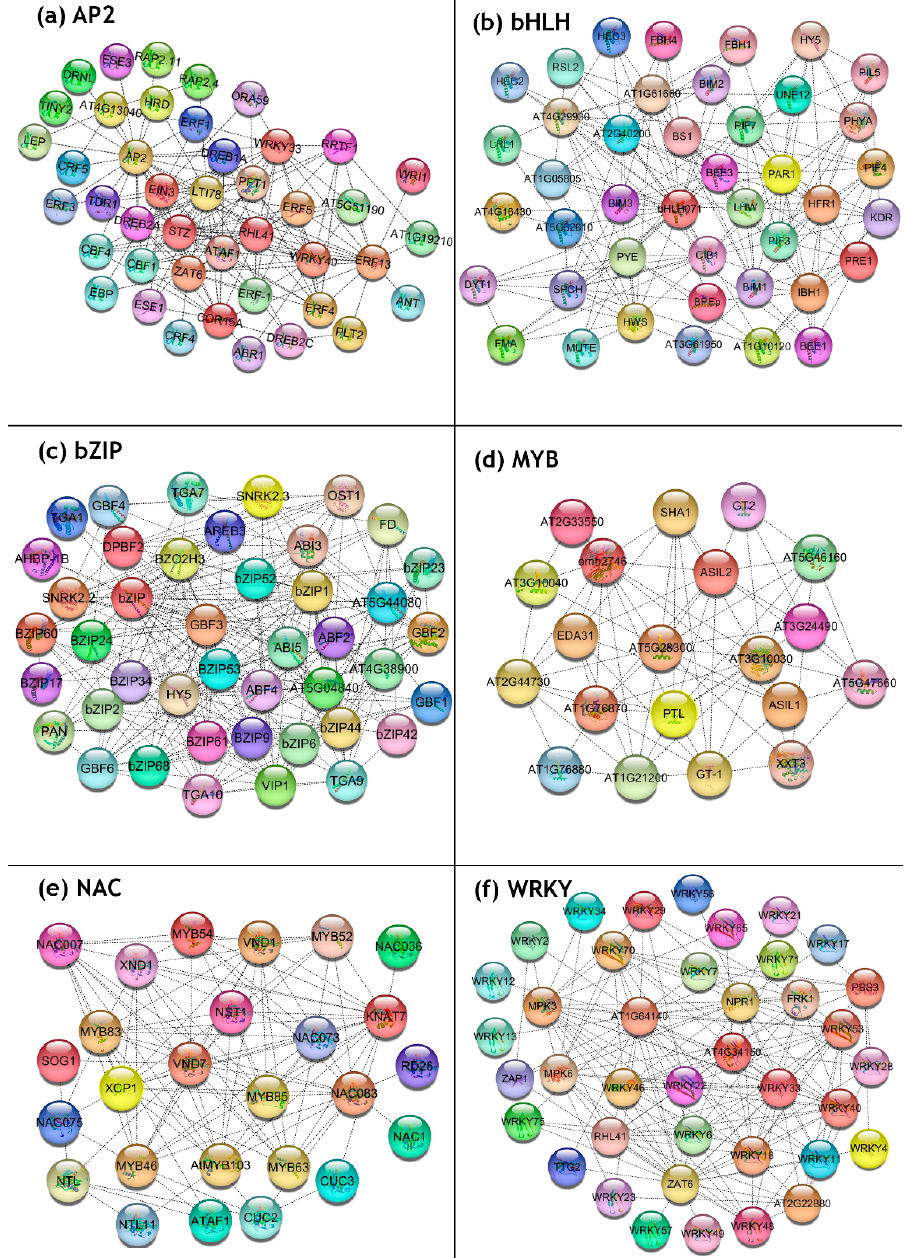
Figure 5. Network analysis of CBCVd-responsive hop TFs in a cluster of orthologous (COG) mode using the STRING v11.0 database showing the interconnected network of hop TFs with other proteins involved in the defense response, with a confidence score ≥ 0.7. The top ten interactions were extracted using the cytohubba app and visualized using Cytoscape software ( a ) AP2 family, ( b ) bHLH family, ( c ) bZIP family, ( d ) MYB, ( e ) NAC, and ( f ) WRKY.